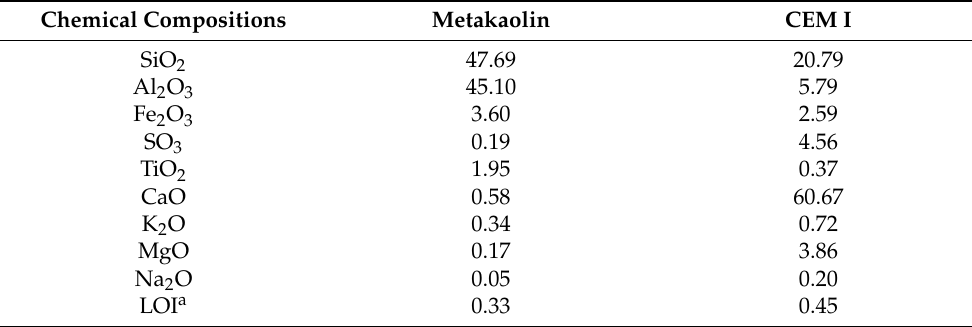
Table 2. Chemical compositions of metakaolin and CEM I (wt%).